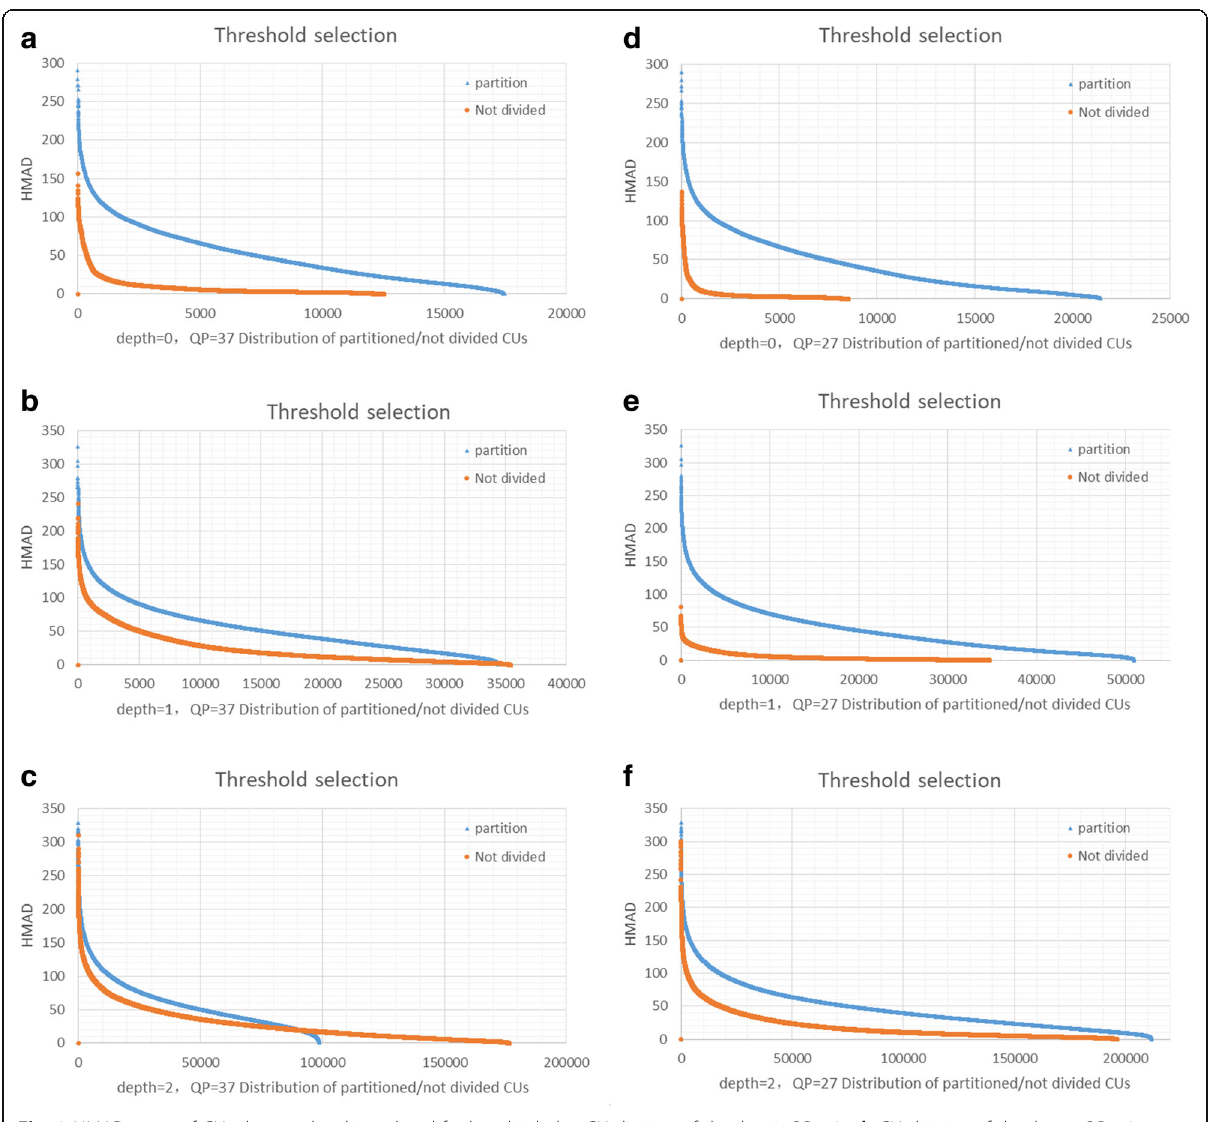
Fig. 9 HMAD maps of CUs that can be skipped and further divided. a CU division of depth = 0, QP = 37. b CU division of depth = 1, QP = 37. c CU division of depth = 2, QP = 37. d CU division of depth= 0, QP = 27. e CU division of depth = 1, QP = 27. f CU division of depth = 2, QP =